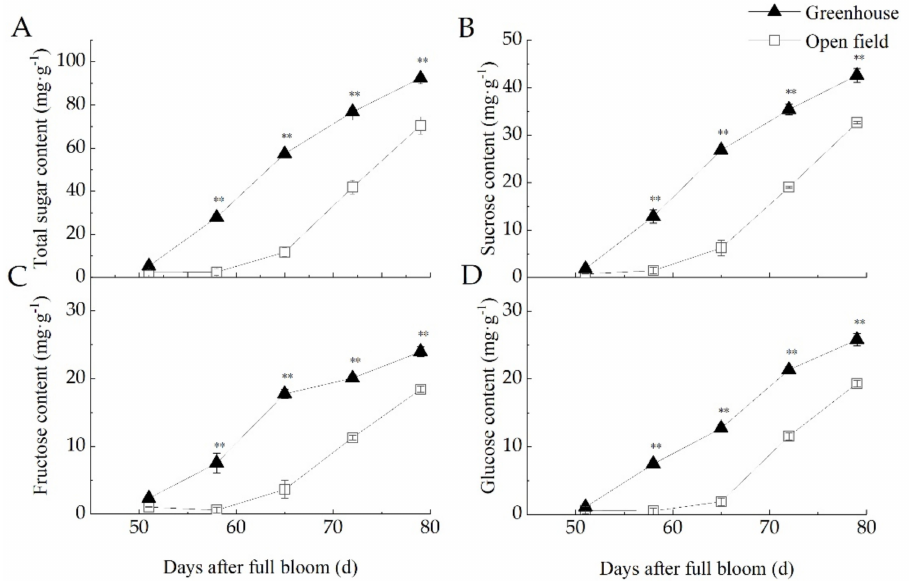
Figure 4. Sugar content of bayberry fruit cultivated in a greenhouse or in the open field. ( A ) Total sugar content of the fruits during bayberry developmental stages. ( B ) Sucrose content of the fruits during bayberry developmental stages. ( C ) Fructose content of the fruits during bayberry develop- mental stages. ( D ) Glucose content of the fruits during bayberry developmental stages. Graphics marked ** are significantly different ( p < 0.01) based on